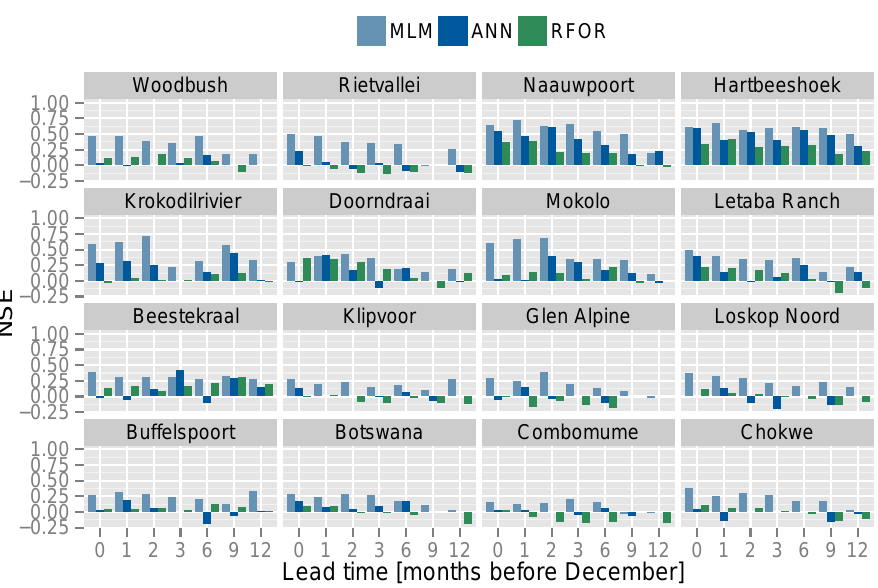
Figure 11. Validation of DJFMAM drought forecasts with LOO-CV Nash–Sutcliffe model efficiency: MLMs (bright blue), ANNs (dark blue) and RFORs (green). Stations are ordered increasingly by catchment area from small (top left) to large (bottom